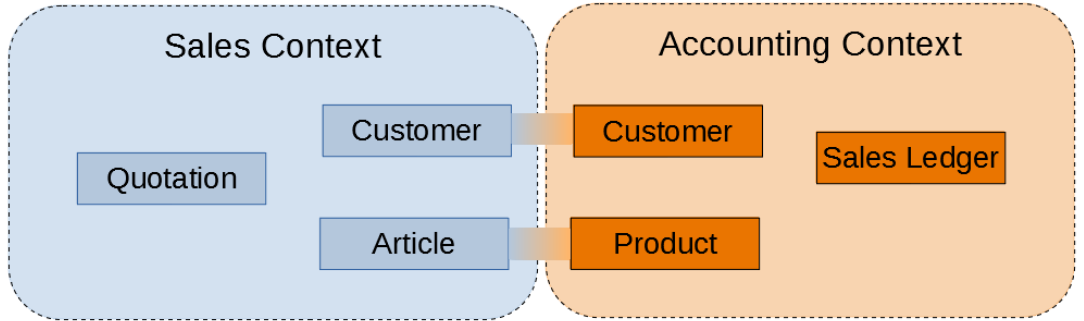
Figure 3. Two bounded contexts in DDD (sales and accounting) with shared concepts for customers and products (articles).